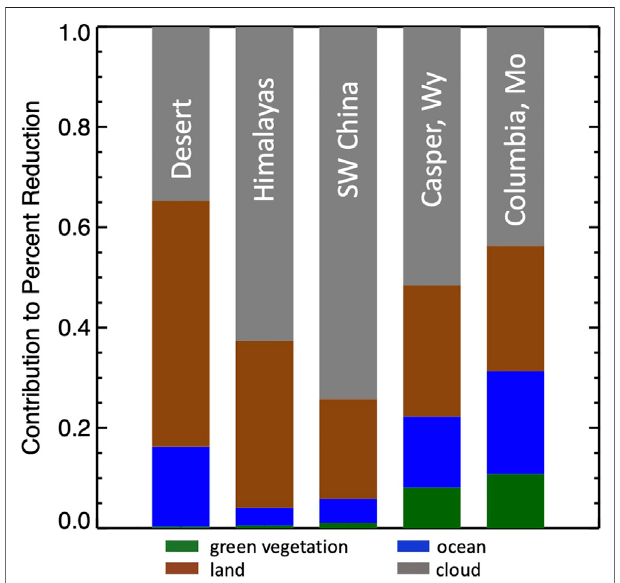
FIGURE 13 | Summary of percentage contribution from different re fl ectors for the three cases during 2020 solar eclipse and two cases during 2017 solar